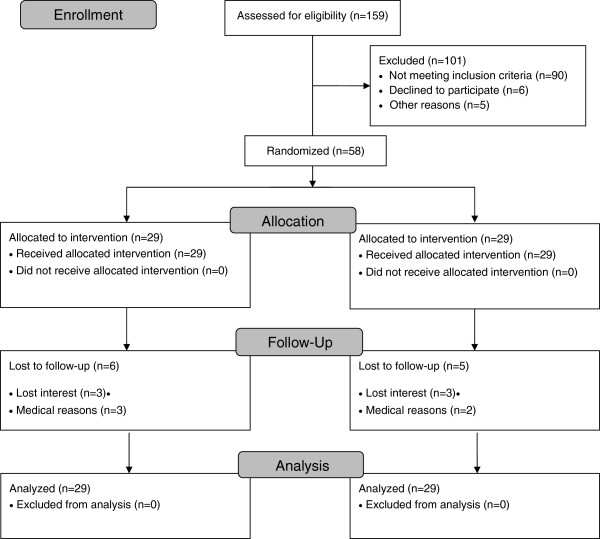
Participant Flow